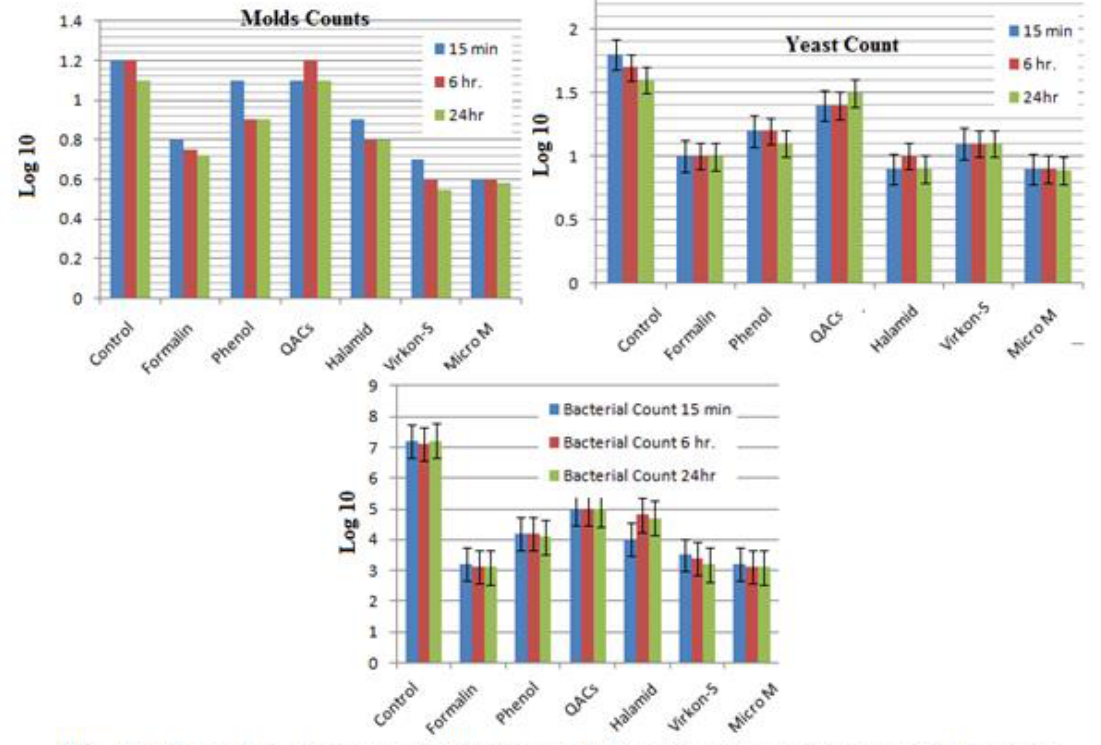
a-b Different superscripts mean significantly different column values